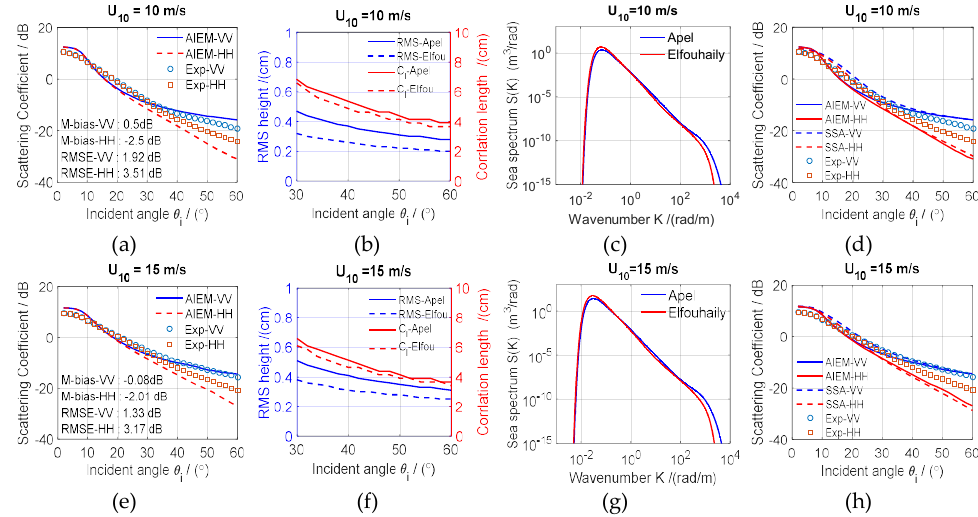
Figure 8. Comparisons of simulated backscattering, predicted by AIEM and SSA-1 model, versus incident angles based on Elfouhaily spectrum for Ku band with NSCAT-4 model at the wind speeds of 10 m/s ( a ), ( d ) and 15 m/s ( e ), ( h ); and the corresponding effective roughness parameters ( b ), ( f ) and spectrum curve ( c ), ( g ).